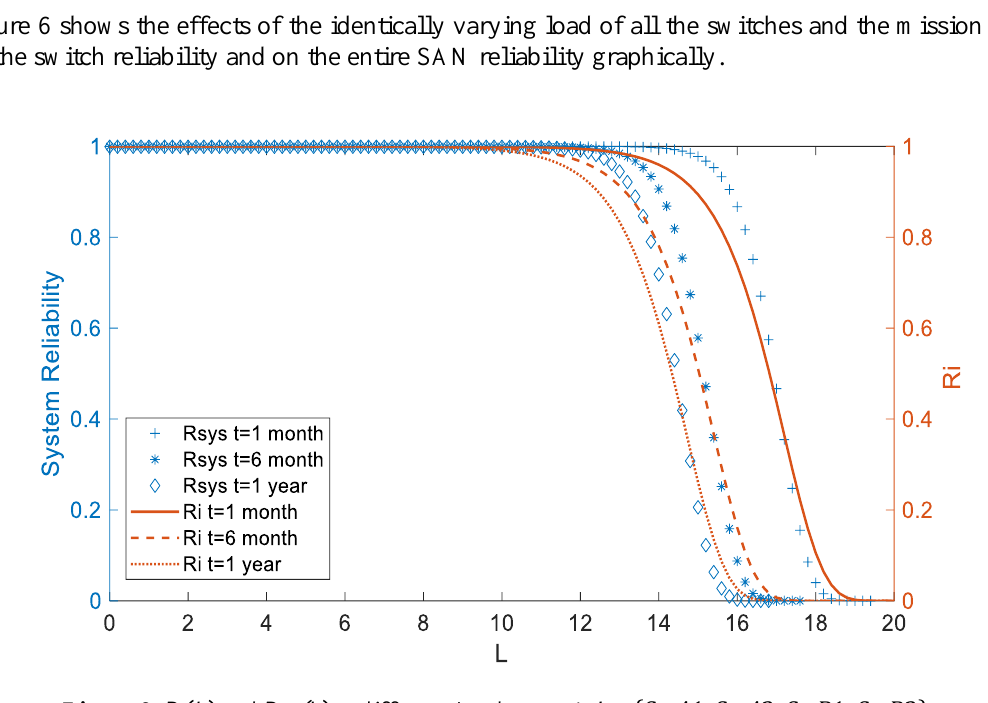
Table 4. Component unreliability 𝐹